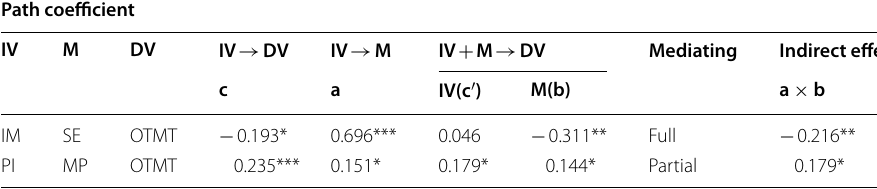
Table 5 Results of mediating